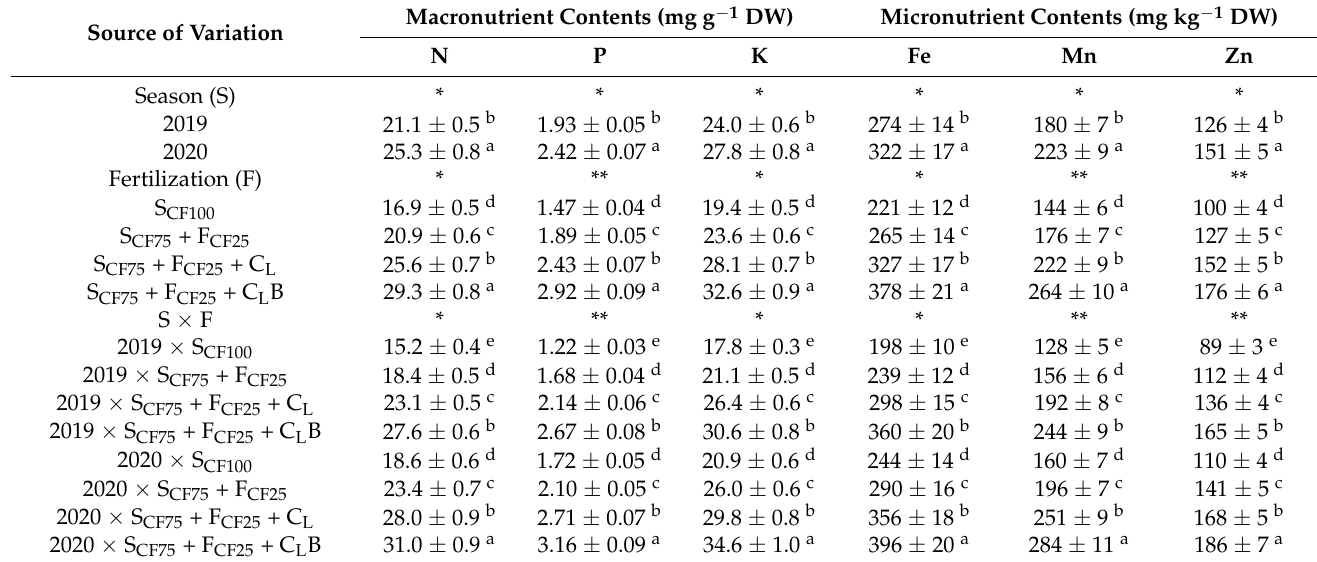
Table 5. Response of nutritional contents of Phaseolus vulgaris plants to growing season (2019 and 2020) and different fertilization strategies applied to virgin sandy soil.